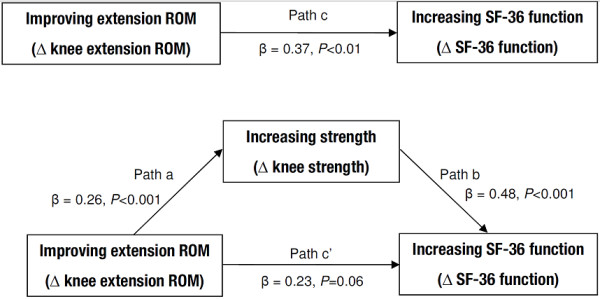
Changes (pre to post TKA) in knee extensor strength mediated the association between changes in knee extension ROM and changes in SF-36 physical function. For presentation clarity, covariates – namely, age, sex, body mass index, number of comorbidities, and changes in SF-36 bodily pain and mental health scores – are not displayed.